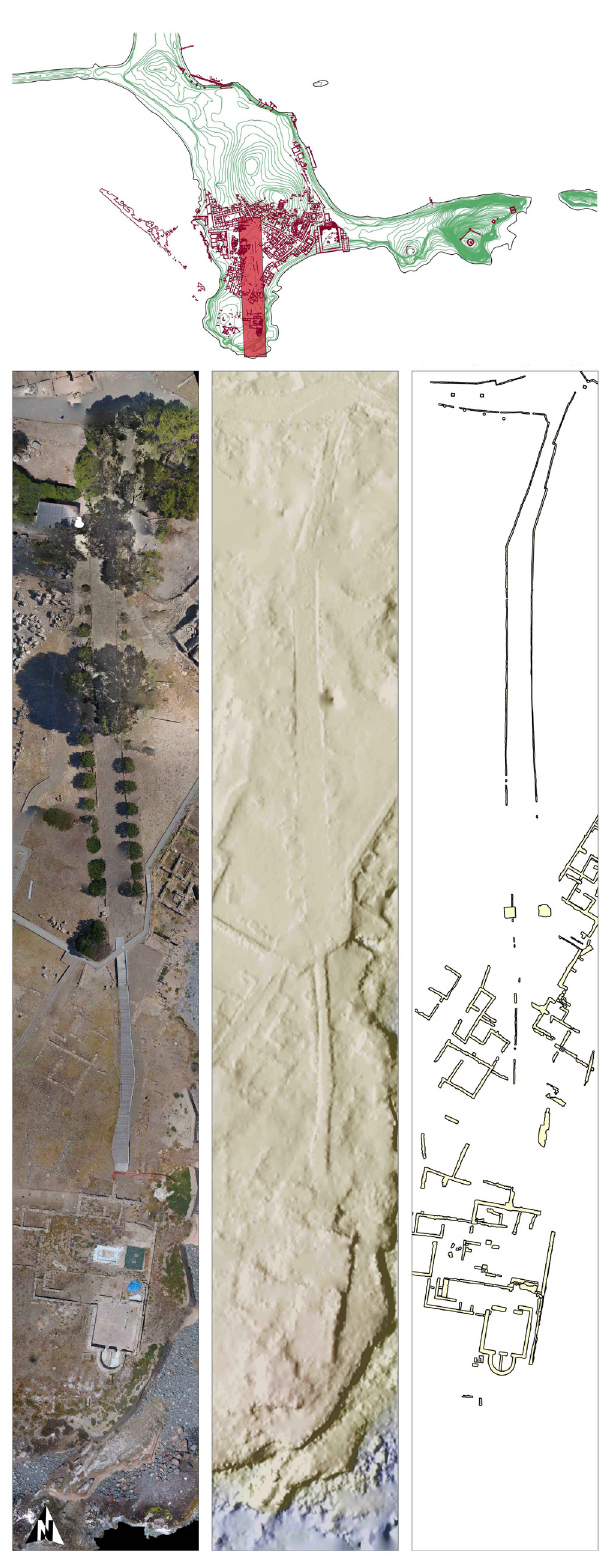
Figure 4. First outcomes of the project. The photogrammetric processing was focused on long area of the site, mapping the sanctuary and the so-called processional road leading to the temple. Orthophoto, DTM and vector maps are the main